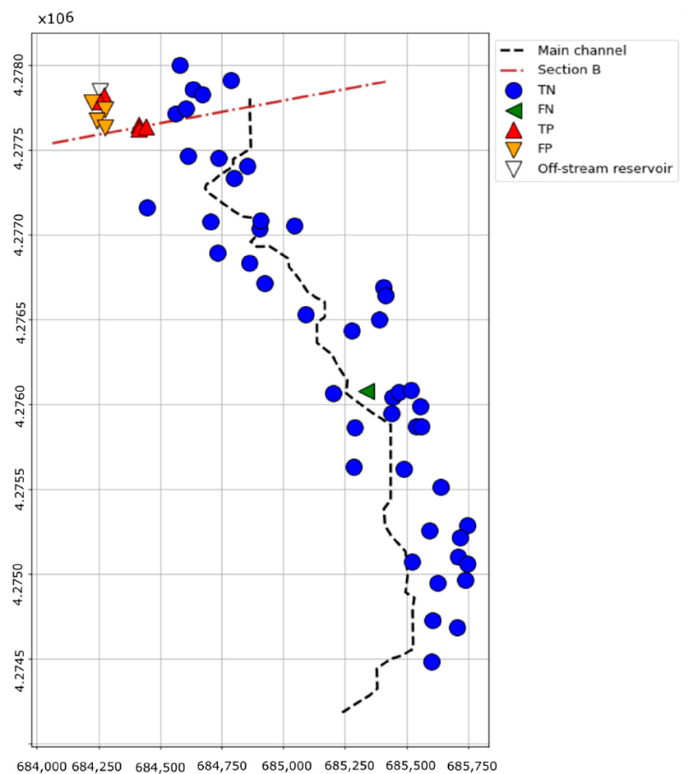
Figure 16. Predictions of the ML model for AoI, compared with the classification from Iber. Axes represent UTM coordinates.